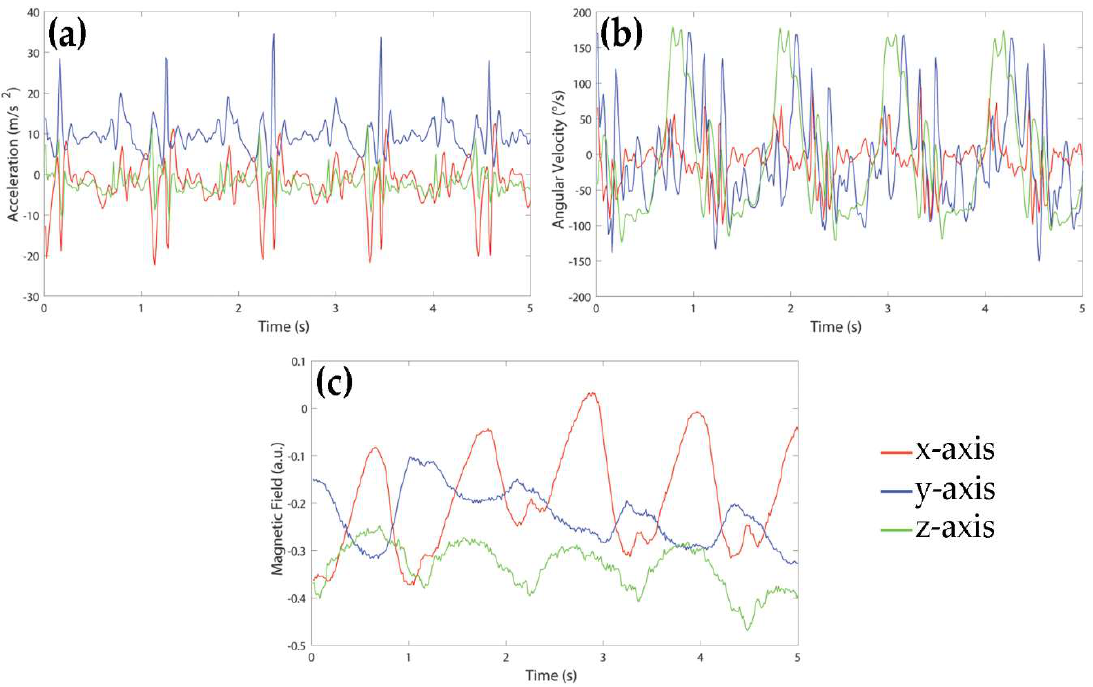
Figure 1. Example of signals acquired by ( a ) accelerometer, ( b ) gyroscope and ( c ) magnetometer during 5 s of walking of a healthy